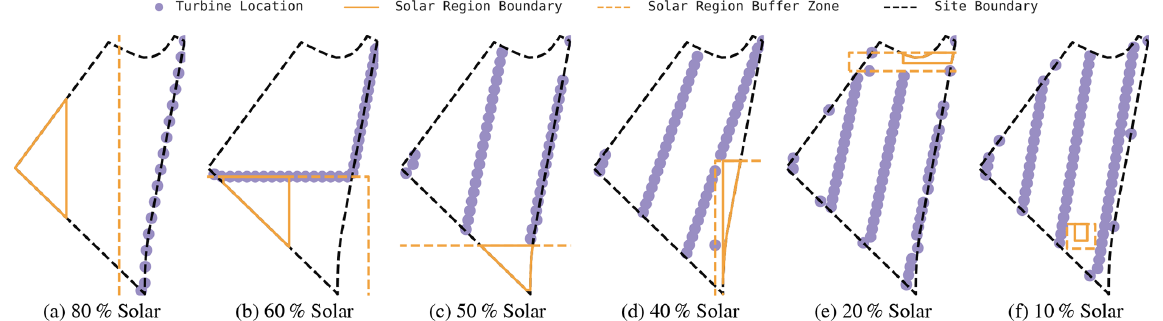
Figure 10. Solutions generated for the high-correlation location and irregular boundary for a range of solar and wind capacity mixes, holding total nameplate capacity at 125MW.